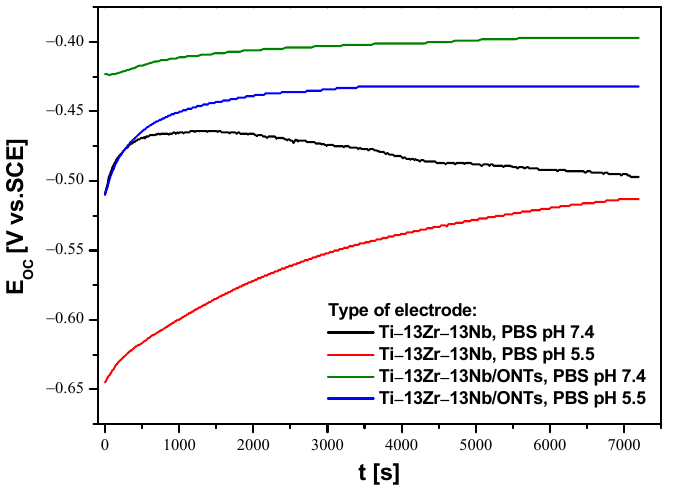
Figure 11. Open circuit potential (E OC ) in the function of immersion time (t) for the Ti–13Zr–13Nb electrode without and with 2G ONTs layer in PBS at 37 °C.